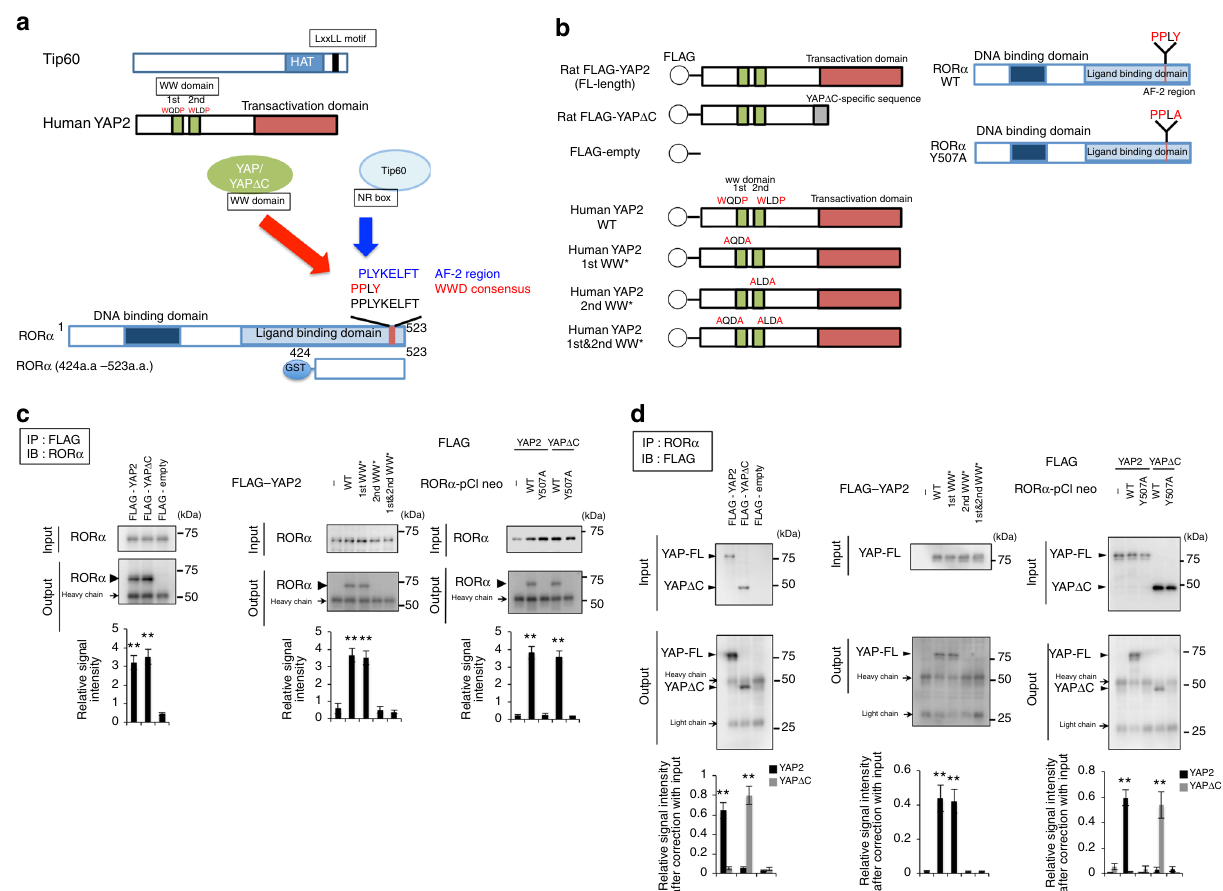
Fig. 3 Structures of ROR α , YAP, and Tip60 and their possible relationship. a Scheme showing the interaction among YAP, Tip60, and ROR α . GST-ROR α (a. a. 424 – 523), used for the pull-down assay in Fig. 5d, is also shown. b Mutants generated for interaction assays. c , d In left panels, immunoprecipitation analyses with primary cerebellar neurons transiently expressing FLAG-YAP2 (full-length YAP) or FLAG-YAPdeltaC show the interaction of endogenous ROR α with YAP or YAPdeltaC. In middle panels, YAP2 mutants of the fi rst and/or second WW domain were also examined for interaction with endogenous ROR α . In right panels, wild-type ROR α and mutant ROR α at the PPLY motif were tested for interaction with FLAG-YAP2/YAPdeltaC. The lower graphs show quantitative analyses of the relative intensities of output bands, corrected based on the corresponding input band ( n = 3). Double asterisks: p < 0.01 in one-way ANOVA with post hoc Tukey ’ s HSD